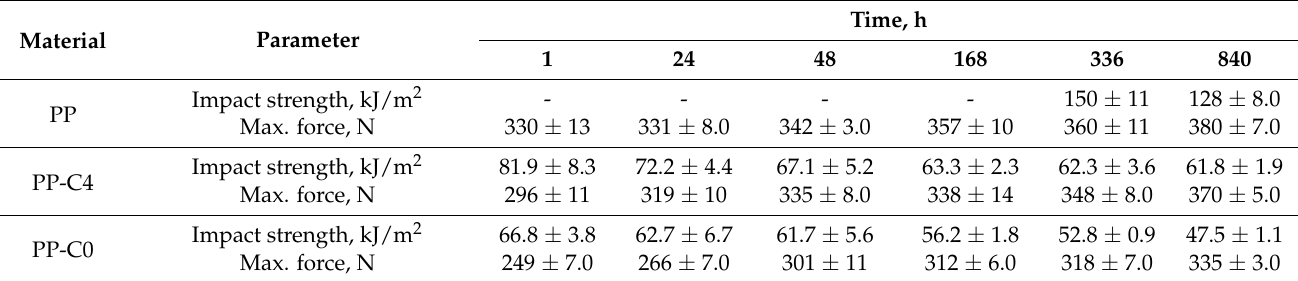
Table 5. Parameters recorded during impact strength measurements.